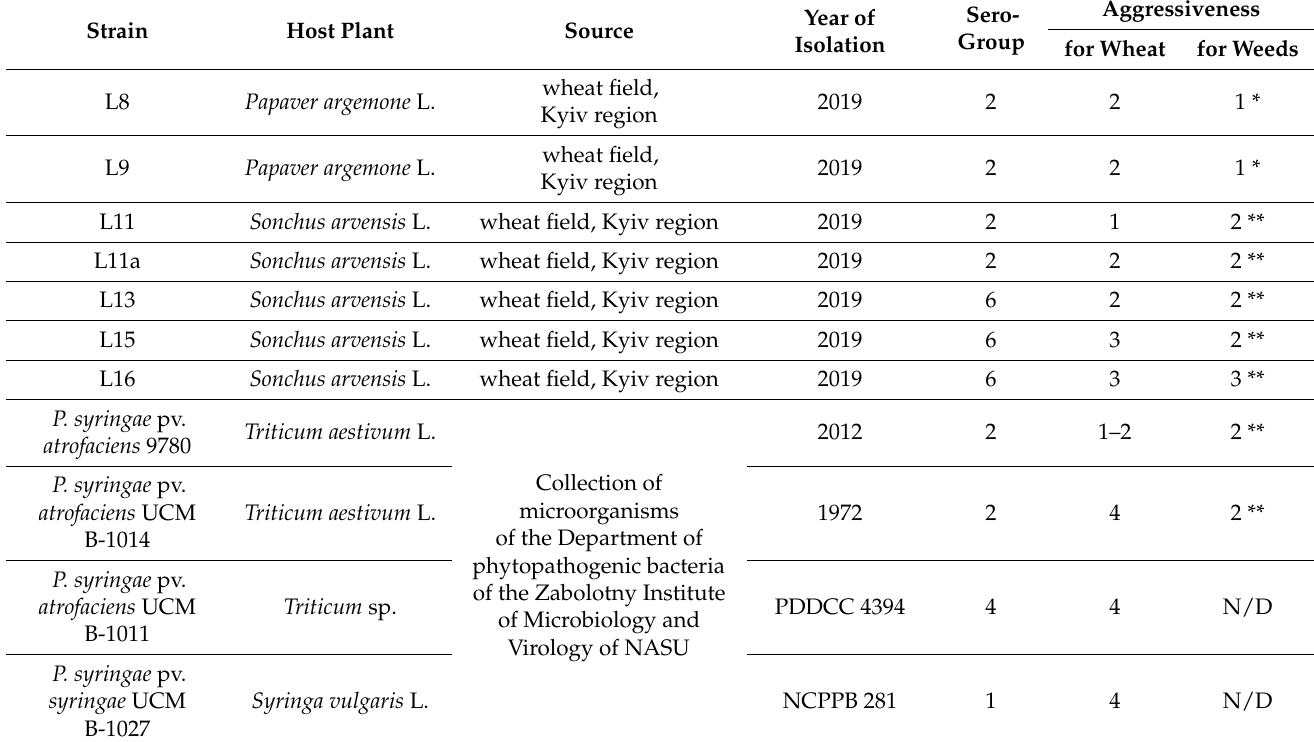
Table 2. Virulence and serological properties of the bacterial strains used in this